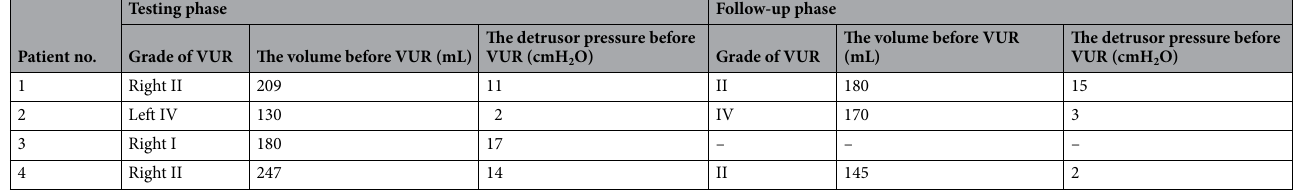
Table 5. Improvement of VUR during the testing and follow-up